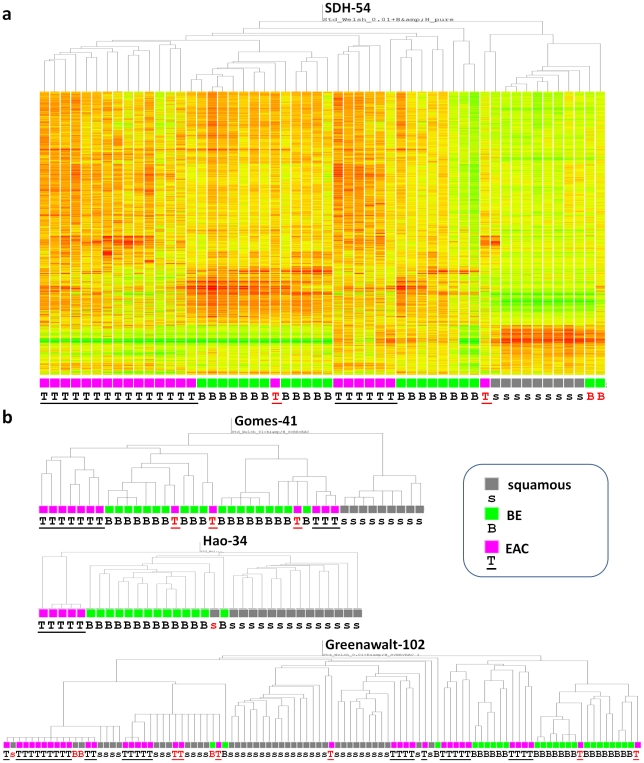
Supervised clustering in 4 cohorts to distinguish squamous, BE and EAC mRNA profiled samples.Cluster diagrams for a) the SDH-54 sample set introduced here and b) three previously published EAC cohorts for which raw data were publically available. Each dataset was clustered using the Genespring ‘Standard’ Algorithm. The gene lists used to cluster each cohort were generated using a Welsh ANOVA test to select genes that discriminate squamous, BE and EAC with a p value threshold <0.01. The Hao-34 sample set required a less stringent (p<0.05) threshold in order to generate genes. For each cohort squamous samples (s) are represented by grey boxes, BE (B) samples by green boxes and EAC (T) tumors by pink boxes. Samples highlighted in red indicate those that did not cluster as expected based on their expected pathology and are referred to in the text as ‘misclassified’.